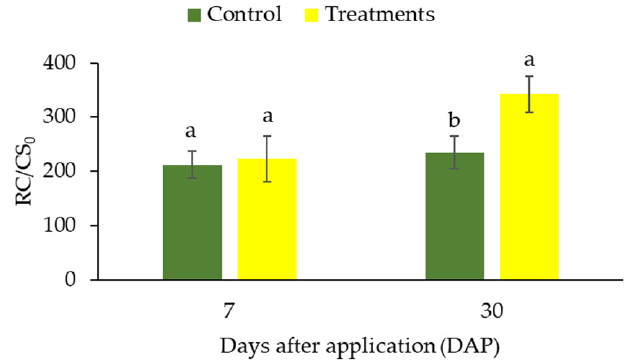
Figure 3. Changes in the ratios RC/CS0 (number of active reaction centers per cross section) in coffee leaves (genotype “153”) submitted to high light after the CC application. The measurements were made after 7 and 30 days of treatment. Before the measurements, leaves were dark-adapted for 30 min. Values are averages for eight plants. The data shows mean value ± standard errors. Averages followed by different lowercase letters in each sampling (7 and 30 days) differ by Tukey’s test, at 5%